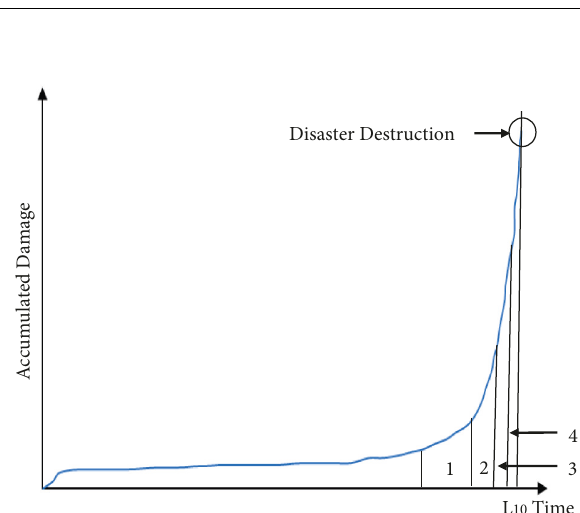
Figure 6: Four stages of rolling bearing fault development ( L the basic rated life of the bearing): (1) initial stage of failure, (2) minor stage of failure, (3) macro stage of failure, and (4) final stage of